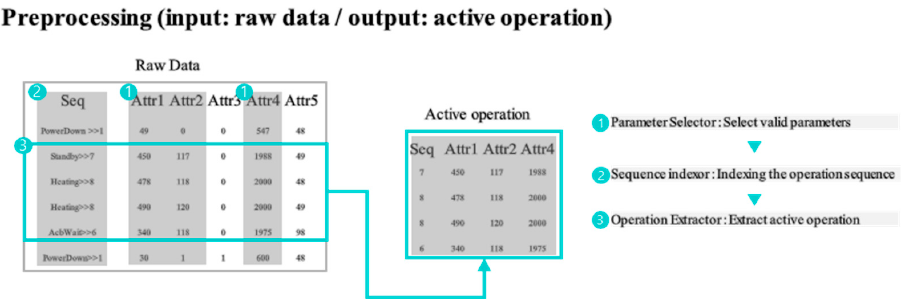
Figure 5. Data preprocessing procedure and I/O. Table 3. Scheme of raw